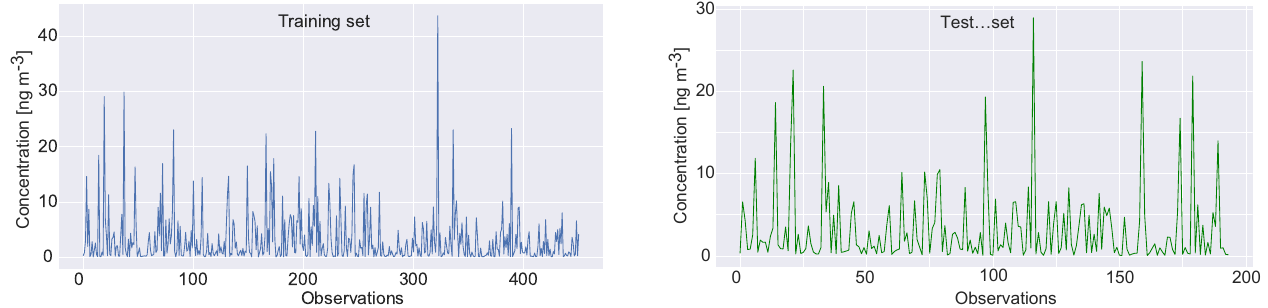
Figure 1. The Benzo(a)pyrene feature dataset